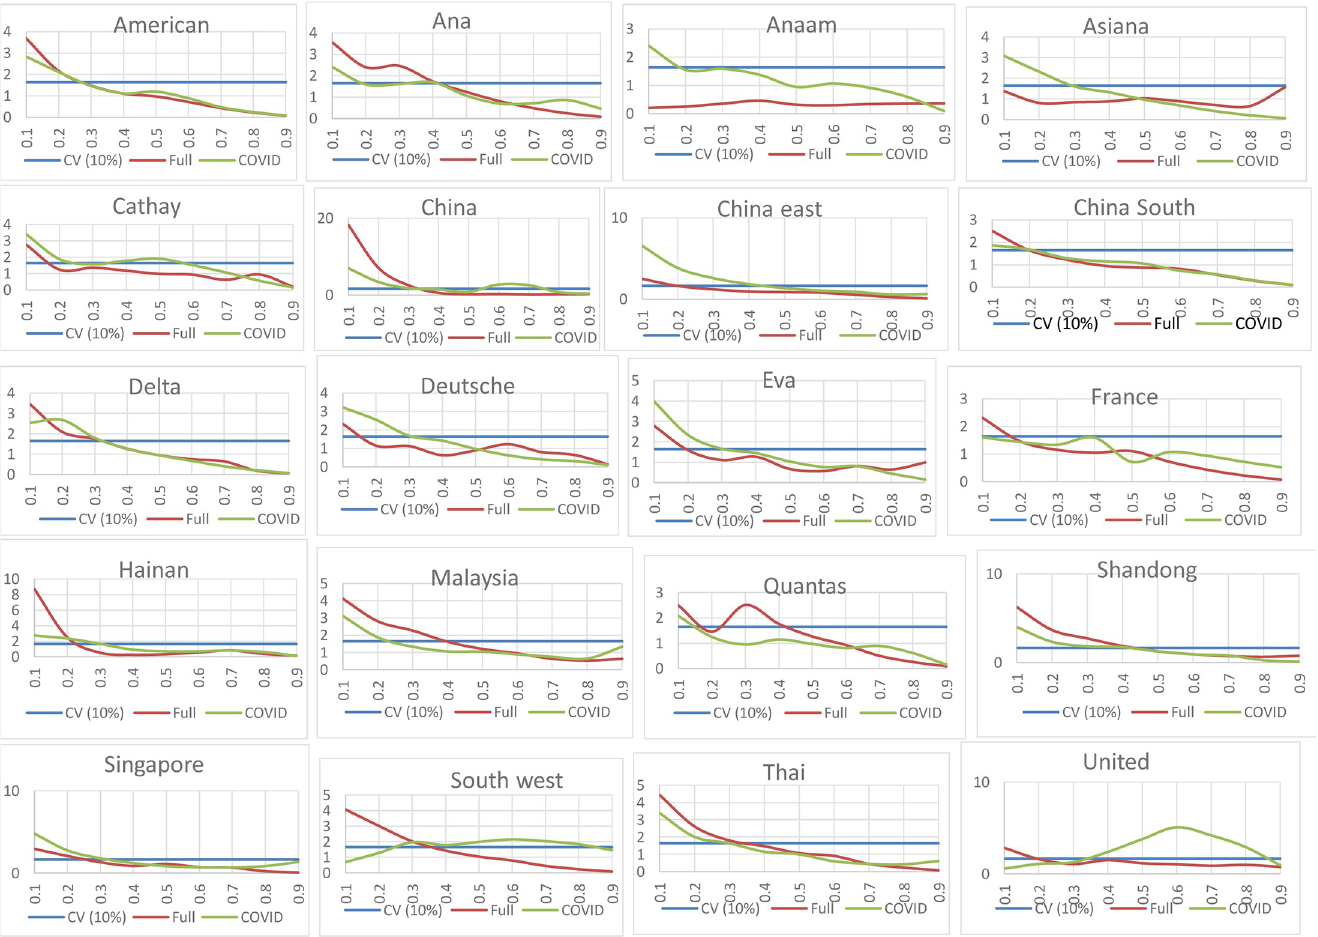
Fig 3. Causality-in-variance result for the airlines. Note: The figure plots the estimates of the nonparametric causality tests of the various quantiles. The y-axis report test statistics and quantiles of the airline stock returns are on x-axis. Full and COVID represents the full sample and COVID-19 pandemic sample, respectively.